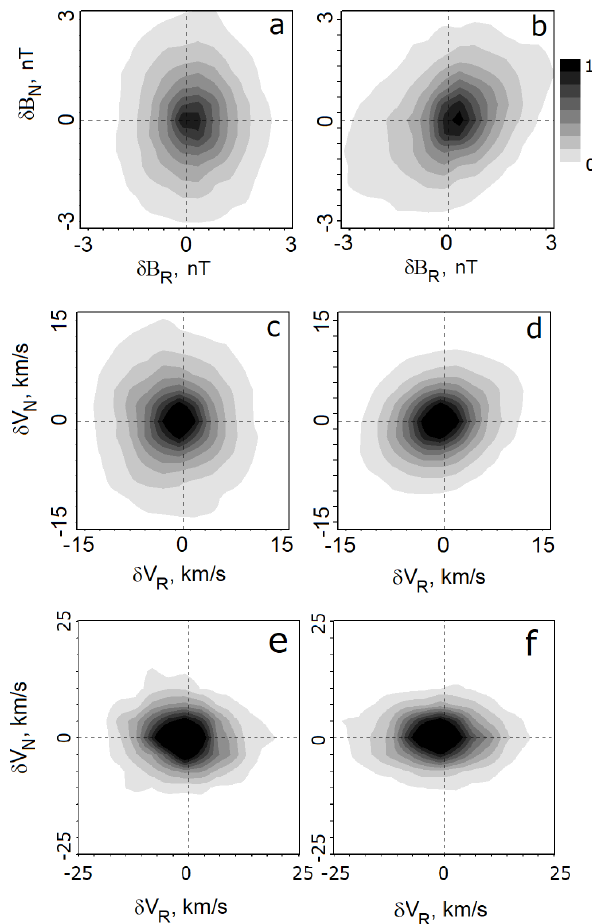
Figure 2. (a) 2D distribution of radial (R) and normal (N) components of magnetic fluctuations occurred in positive magnetic sector dur- ing period of high solar activity in years 2012–2015. (b) the same for period of solar cycle minimum (years 2018–2020). (c) and (d) show the same as in (a) and (b), but for fluctuations of velocity with periods <5 hr. Parts (e) and (f) indicate the same as in (c) and (d), but for velocity fluctuations with periods >5